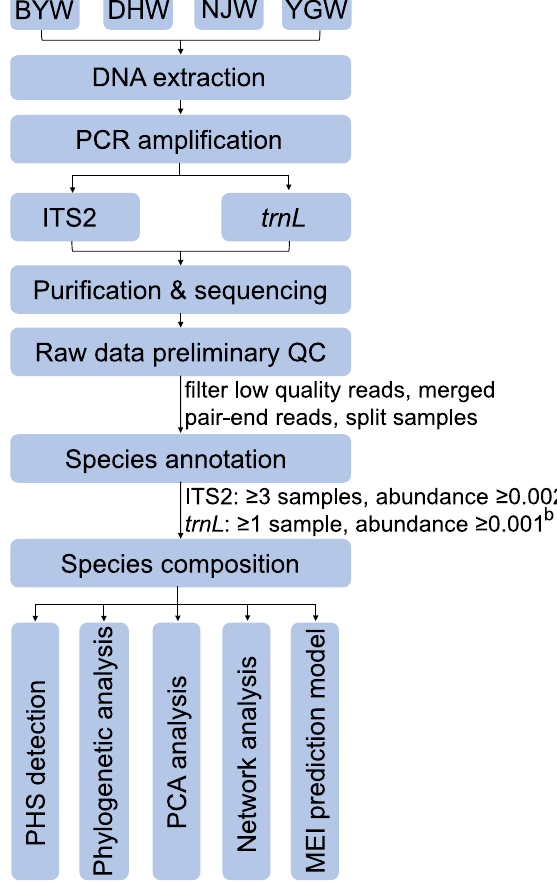
Figure 8. A workflow for TCM preparation analysis procedures. This workflow mainly includes four parts: (1) TCM preparations collection: Baizhen Yimu Wan (BYW), Da Huoluo Wan (DHW), Niuhuang Jiangya Wan (NJW), and Yougui Wan (YGW); (2) Samples preparation and sequencing: DNA extraction, PCR amplification, purification, sequencing; (3) Quality control: raw reads filtering and the species filtering; (4) Species identification and samples comparison: prescribed herbal species (PHS) detection, substituted herbal species (SHS) detection, contaminated herbal species (CHS) detection, the phylogenetic analysis, PCA analysis, network analysis, and Microbial-based environment index (MEI) prediction model for TCM preparations